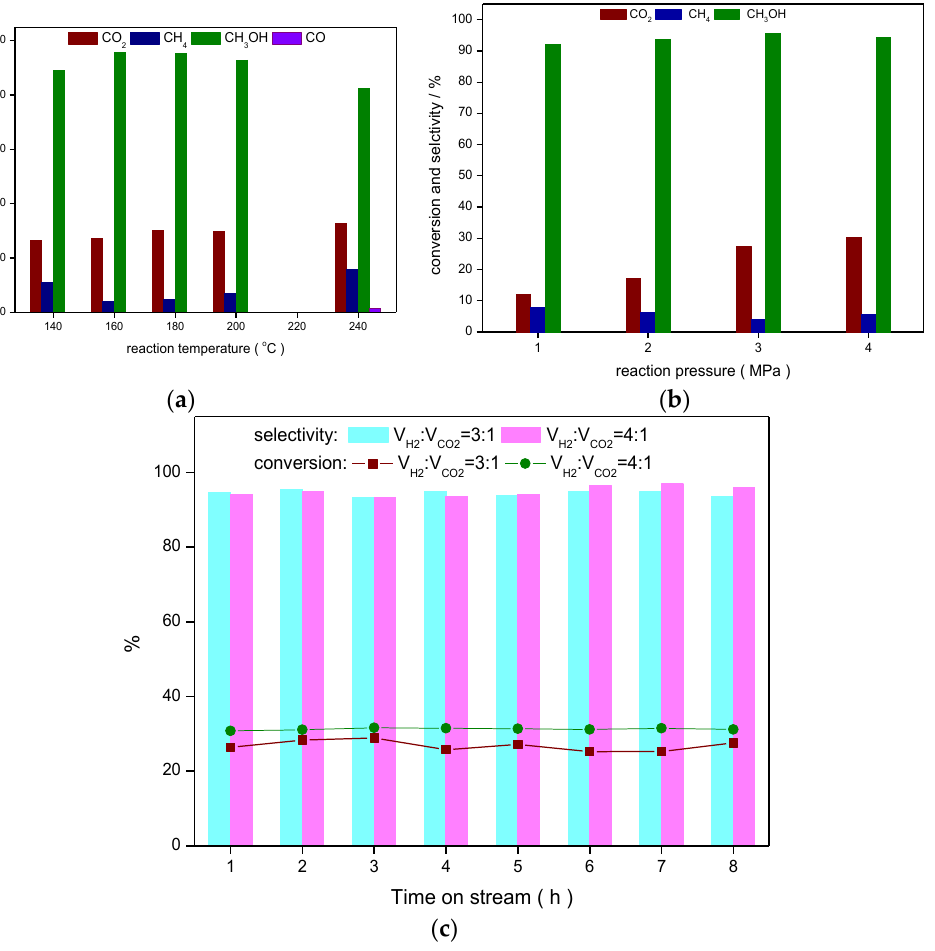
Figure 5. Optimized reaction conditions: ( a ) reaction temperatures, ( b ) reaction pressures, ( c ) ratio of H 2 to CO 2 .